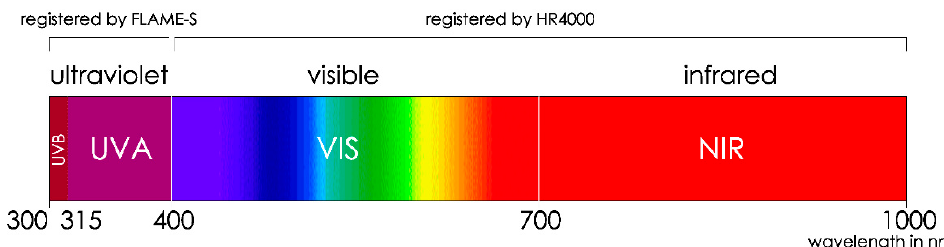
Figure 3. Spatial distribution of recording points [35].